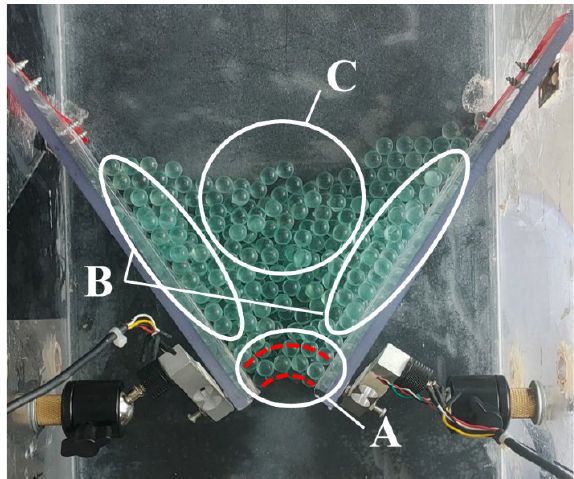
Figure 9. Schematic diagram of particles jamming in the inclined baffle structure, in which the white circle is the divided particles that have different effects on jamming, and the red dotted line is the arch structure formed by the particles at the opening. ( A ) is the arch forming area; ( B ) is the extrusion area; ( C ) is the impact area.